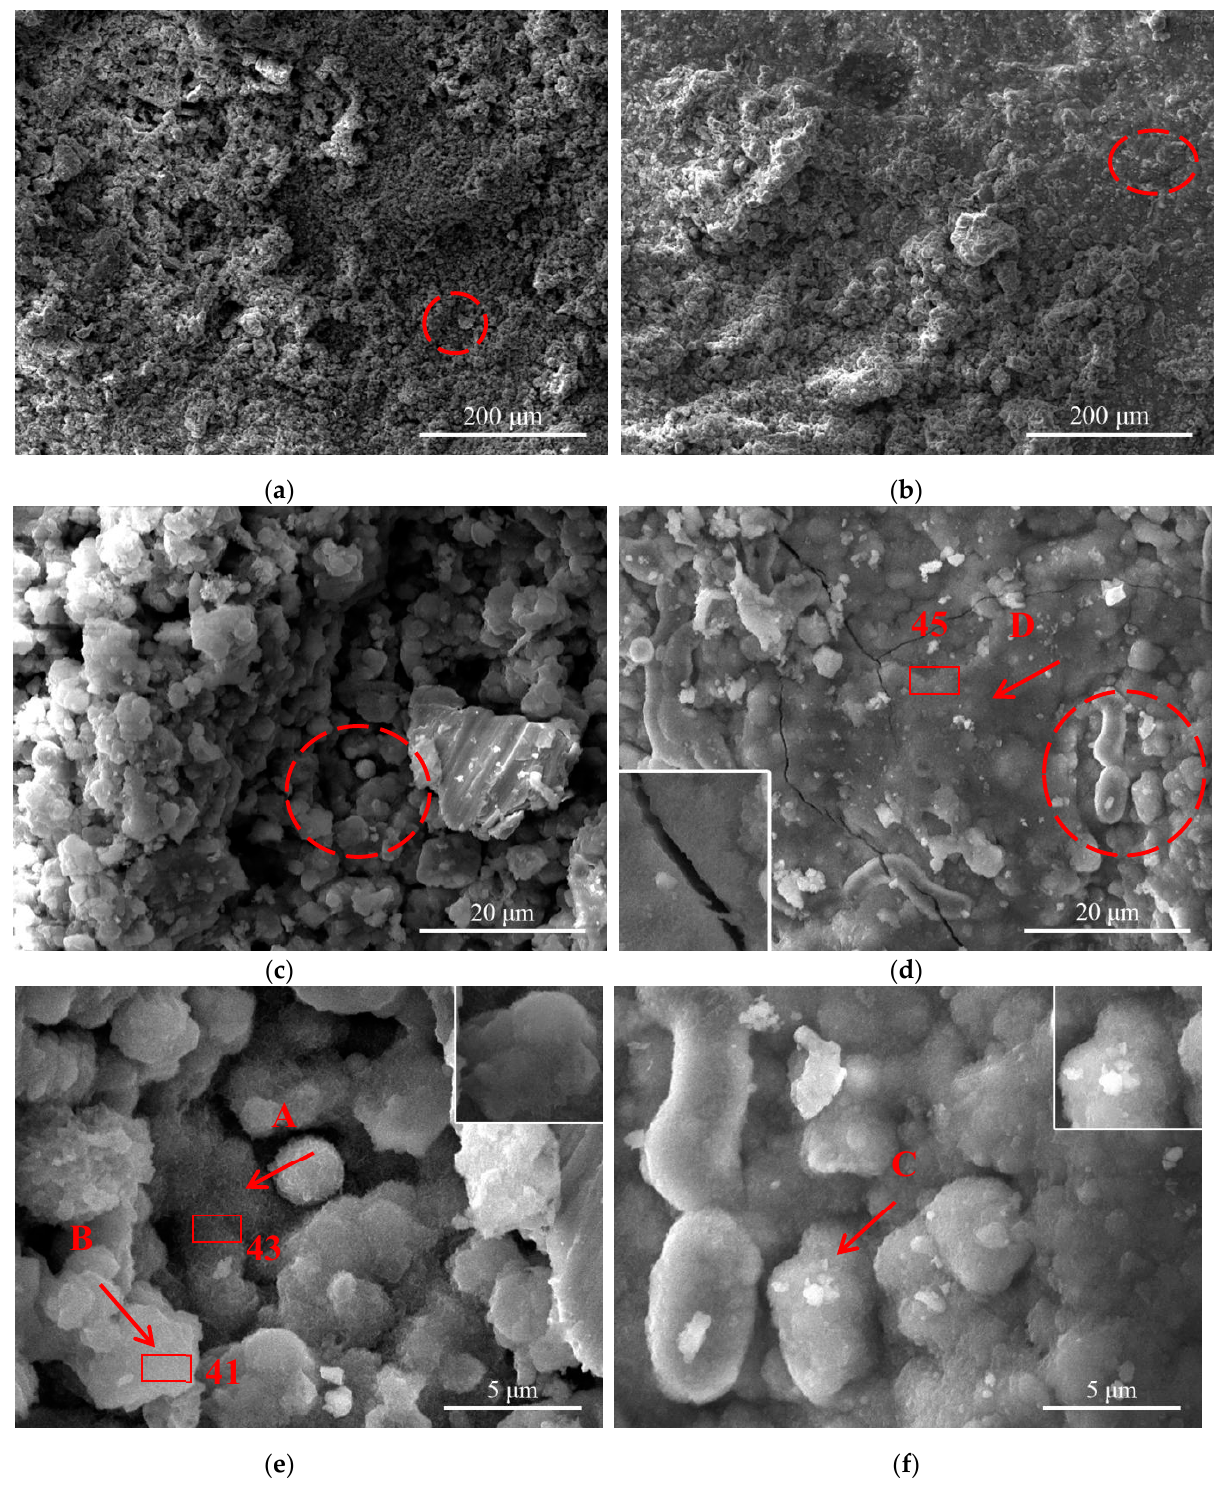
Figure 7. Surface microscopic morphologies of the rust layer and EDS analyses after 84 months of atmospheric exposure.